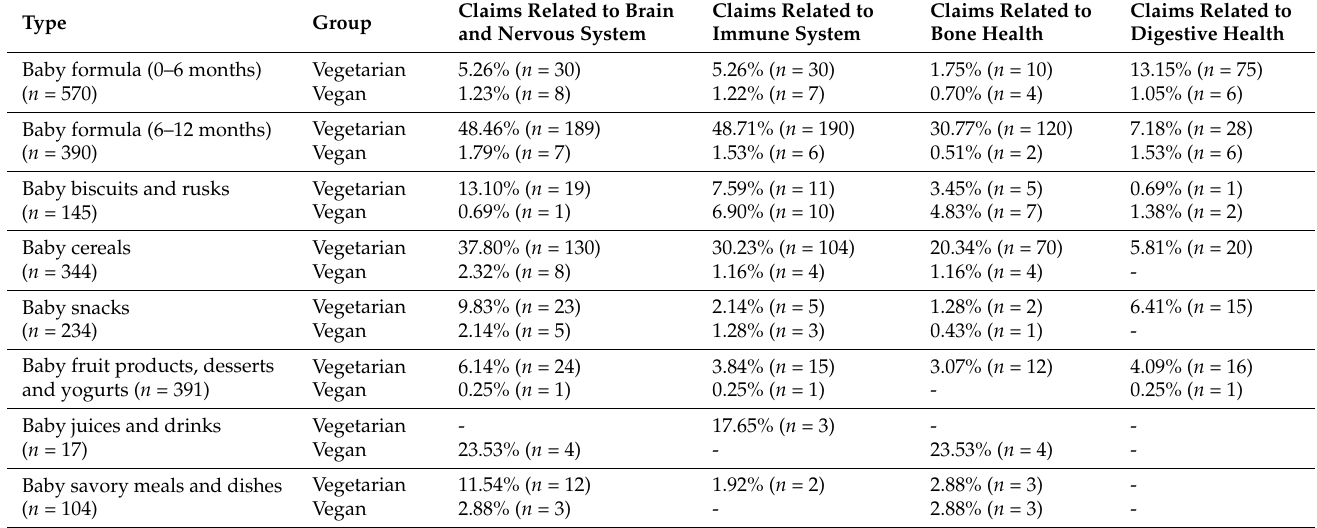
Table 5. Top health claims of plant-based infant